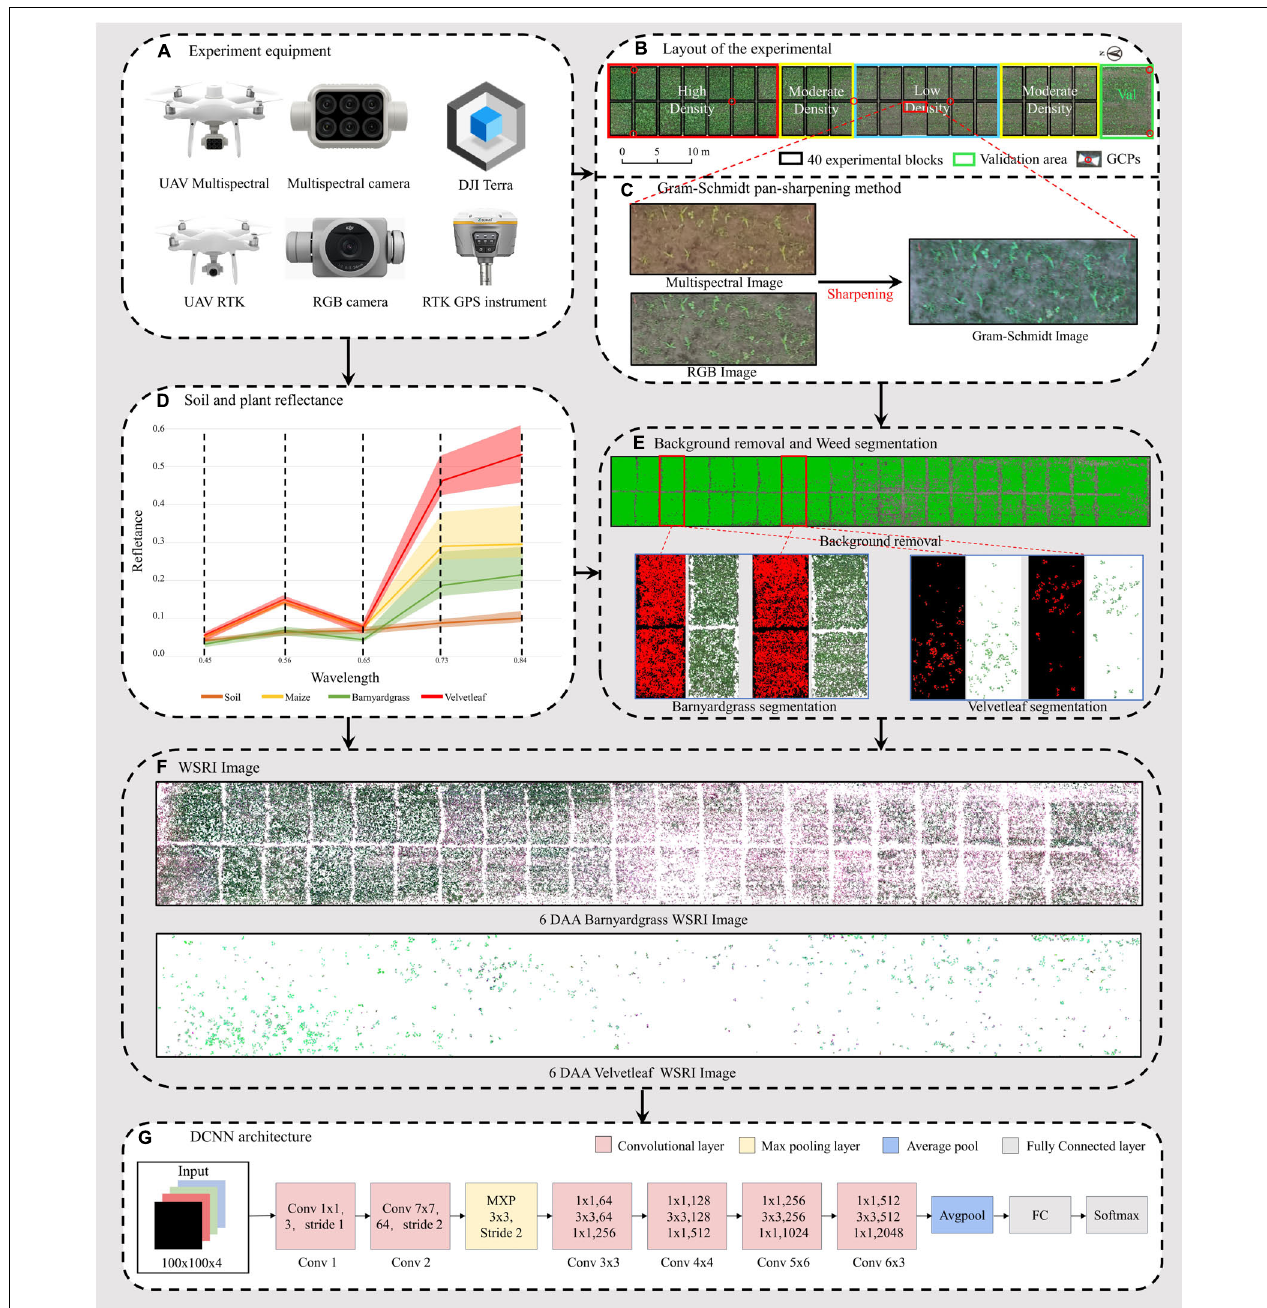
FIGURE 2 | Workflow of the unmanned aerial vehicle (UAV) high-throughput field weed resistance approach. (A) DJI Phantom 4 Multispectral, DJI Phantom 4 RTK, DJI Terra, and RTK GPS instrument for collecting field images. (B) Digital orthophoto maps (DOM) of three maize field densities (low, moderate, high) for weed resistance research. (C) Gram–Schmidt sharpening for improving spectral image information. (D) Reflectance values of four objects in the orthophoto (soil, maize, barnyardgrass, and velvetleaf). (E) Soil and maize removal and two types of weed segmentation, including barnyardgrass and velvetleaf. (F) Two weed image datasets from 6 days after atrazine application (6 DAA) used in the classification models. (G) Deep convolutional neural network (DCNN) architecture.